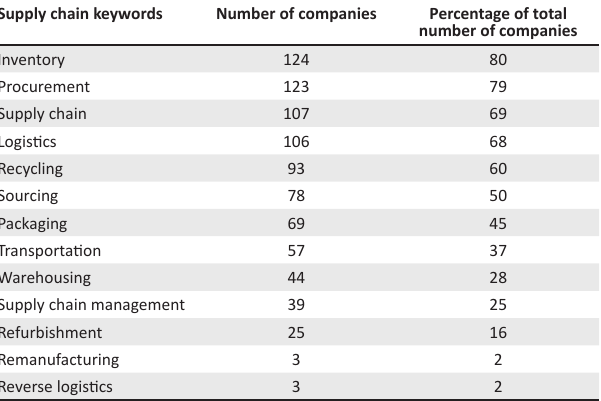
TABLE 2: Inclusion of supply chain–related keywords.